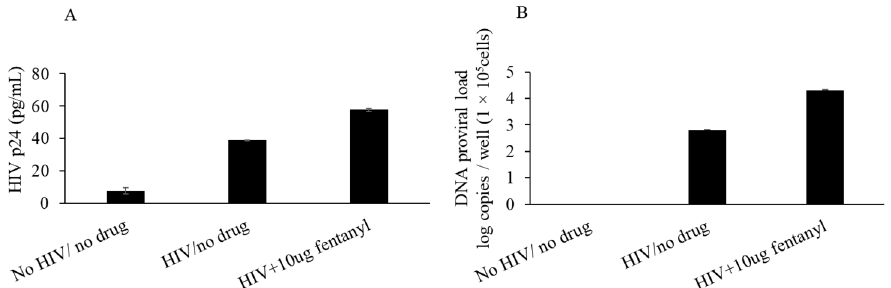
Figure 8. PBMC derived T cells were seeded at ~1 × 10 5 cells per well. Cells were infected with HIV NL4-3 at MOI of 1 for 2 h, rinsed with RPMI + 10% FBS + 1% antibiotics (Pen/Strep) + 1% glutamine three times to remove any unbound virus and -replaced with fresh media. Fentanyl at concentration of 10 ug/mL was added to the respective wells and incubated. HIV p24 antigen expression was estimated from the cell culture supernatant ( A ), and HIV proviral DNA was quantified in cells with real-time PCR based on SYBR Green I detection on day 3 ( B ). Error bars represent the standard deviations between the replicates.